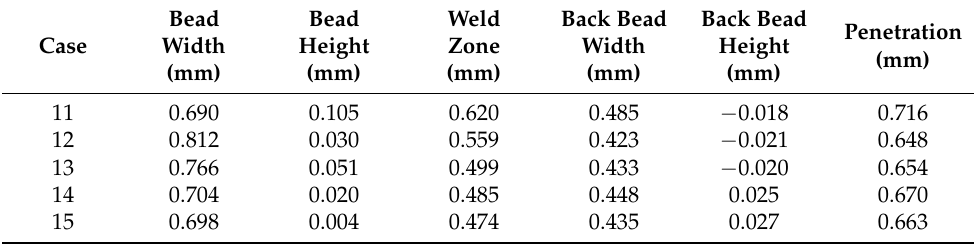
Table 6. Sectional observation measurement